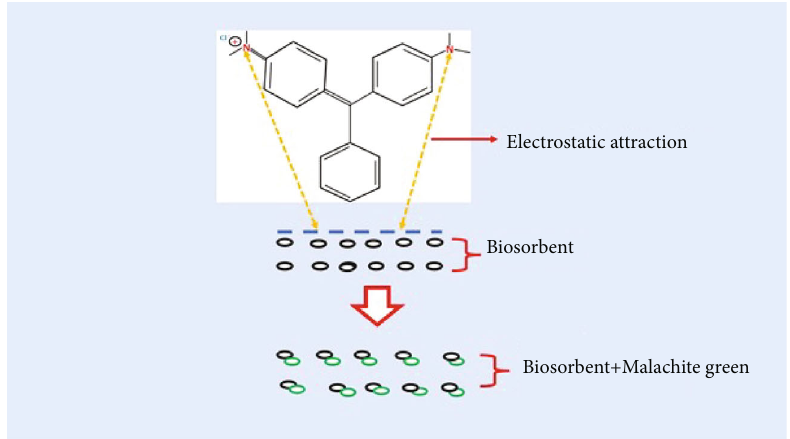
Figure 13: Proposed mechanism of MG adsorption to the